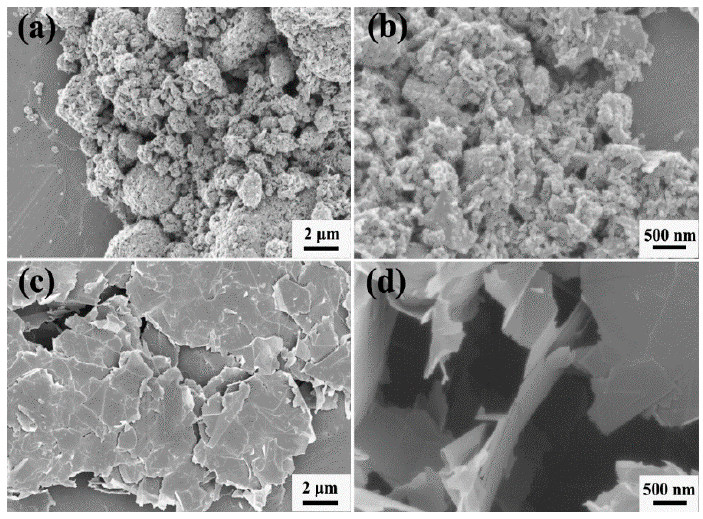
Figure 1. SEM images of ( a ) GnP-C750, ( b ) high magnification of GnP-C750 after sonication, ( c ) GnP-5, ( d ) high magnification of GnP-5 after sonication.